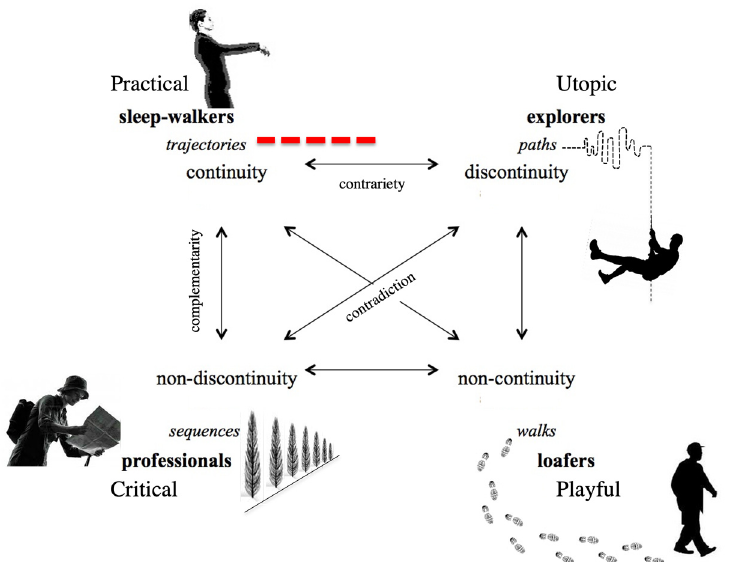
Figure 4. Axiological quadrangular pa tt ern (source: [151], modi fi ed by authors).